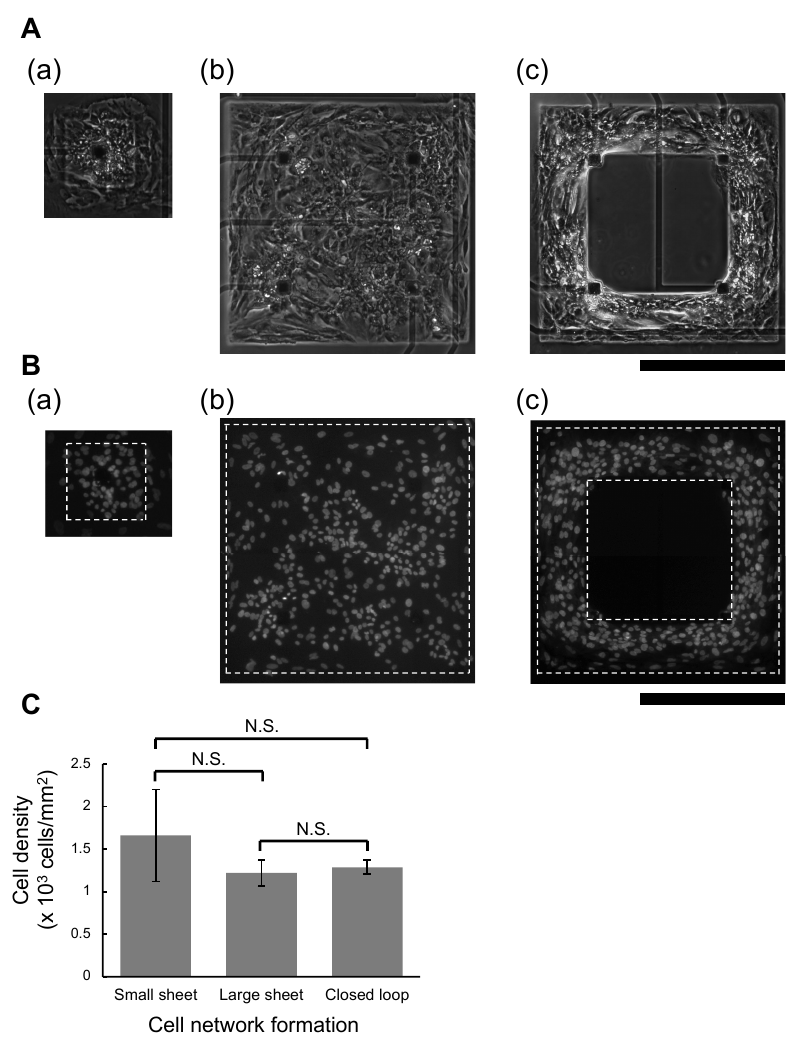
Figure 2. Cultured cardiomyocyte networks in three patterns of agarose microstructures. ( A ): Representative micrographs of three different spatial cell arraignment types of hES cardiomyocyte networks cultured on an MEA chip for seven days. ( a ): cardiomyocyte network in small sheet shape agarose microchamber. ( b ): cardiomyocyte network in large square sheet shape agarose microcham- ber. ( c ): cardiomyocyte network in square closed-loop-shaped sheet shape agarose microchamber. Bars, 0.5mm. ( B ): representative fluorescent micrographs of hES cardiomyocyte networks. B ( a – c ) cor- respond to stained of the nuclei of A ( a – c ), respectively. The nucleus of each cell was stained by nuclear staining fluorescent dye, DAPI, after the measurement of extracellular field potentials (FPs). Bars, 0.5mm. ( C ): cell densities of hES cardiomyocyte networks in three patterns of agarose microchambers (n = 3 each). Bars and error bars represent mean values and S.D. in three patterns, respectively. No significant differences (N.S.) were observed between